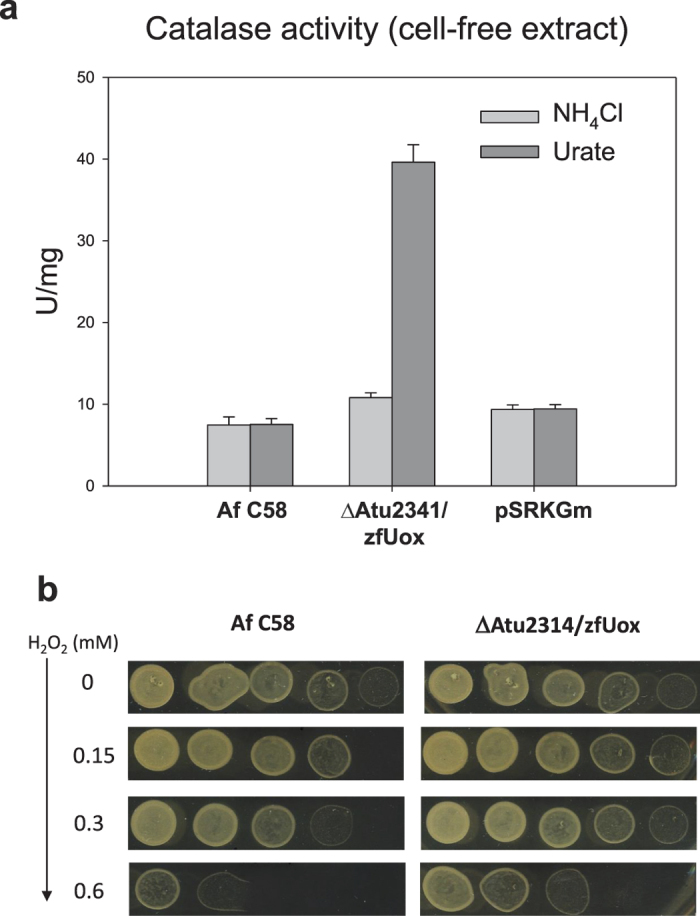
Catalase activity of PuuD and zfUox encoding strains grown on ammonia or urate.(a) Catalase activity (U/mg) of free-cell extracts obtained by sonication of urate- and ammonia-grown cells collected during the exponential growth phase; pSRKGm designates Af C58 cells transformed with the empty vector. Error bars represent standard deviation obtained from three independent experiments. (b) Urate-grown strains plated on LB agar supplemented with increasing concentrations of hydrogen peroxide. Cells were collected during exponential growth phase, diluted at OD600 = 0.1 and spotted at progressive dilutions (1, 1:5, 1:25, 1:125, 1:625). Scanned plate images were adjusted with −40% luminosity and +40% contrast.